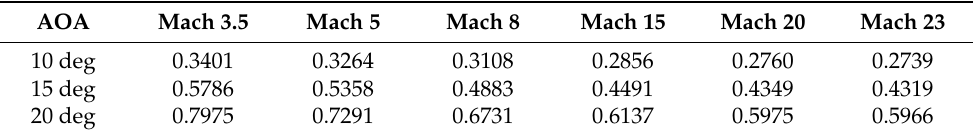
Table A1. CAV-L Lift Coefficient ( C L ).